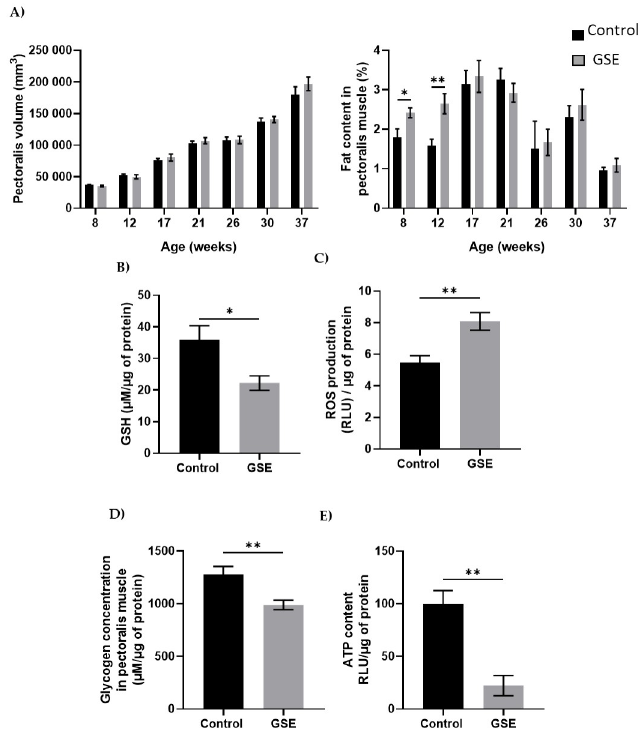
Fig 2. Muscle development. (A) Volume of a section of the right pectoralis muscle (left panel) and percentage muscle fat content (right panel) in male chickens was measured from weeks 8 to 37 (n = 10 animals) was assessed by CT scan every month. (B ) Level of Reactive Oxygen Species (ROS, H 2 0 2 , expressed in Relative Luminescent Units/ μ g of protein) and GSH content ( μ M/ μ g of protein) (C ) was measured in muscle (n = 5 per group). (D) Glycogen ( μ M/ μ g of protein) (E ) and ATP content were measured in the pectoralis muscle (n = 5 per group). Results are presented as means ± SEM. � , p < 0.05. �� , p < 0.01.